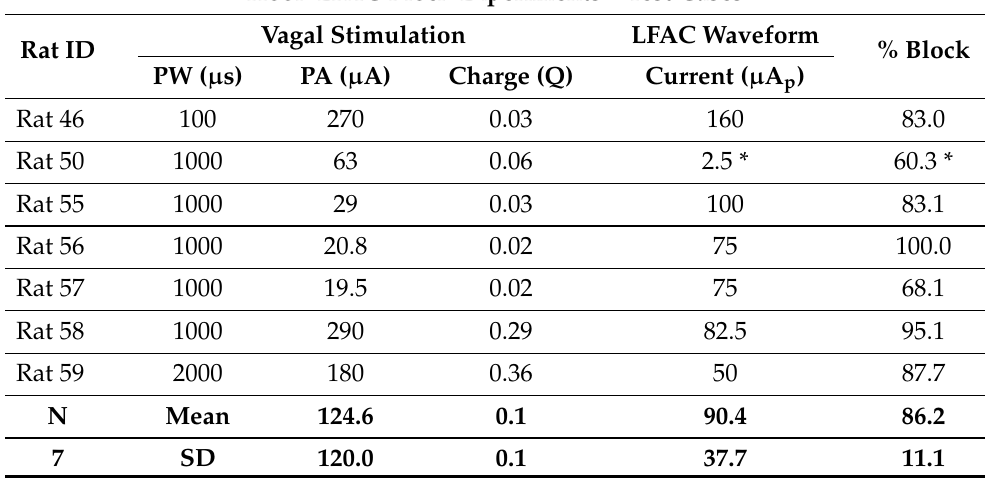
Table 1. Vagal stimulation and LFACb waveform parameters used in the set of 7 rats in this study. The conditioning waveform was applied via a hook electrode in this set. The average percent block amongst n = 7 experiments was found to be 86.2 ± 11.1%. * Instrumentation connection issues did not allow currents > 2.5 µ A. Nonetheless, ∼ 60% block was achieved.